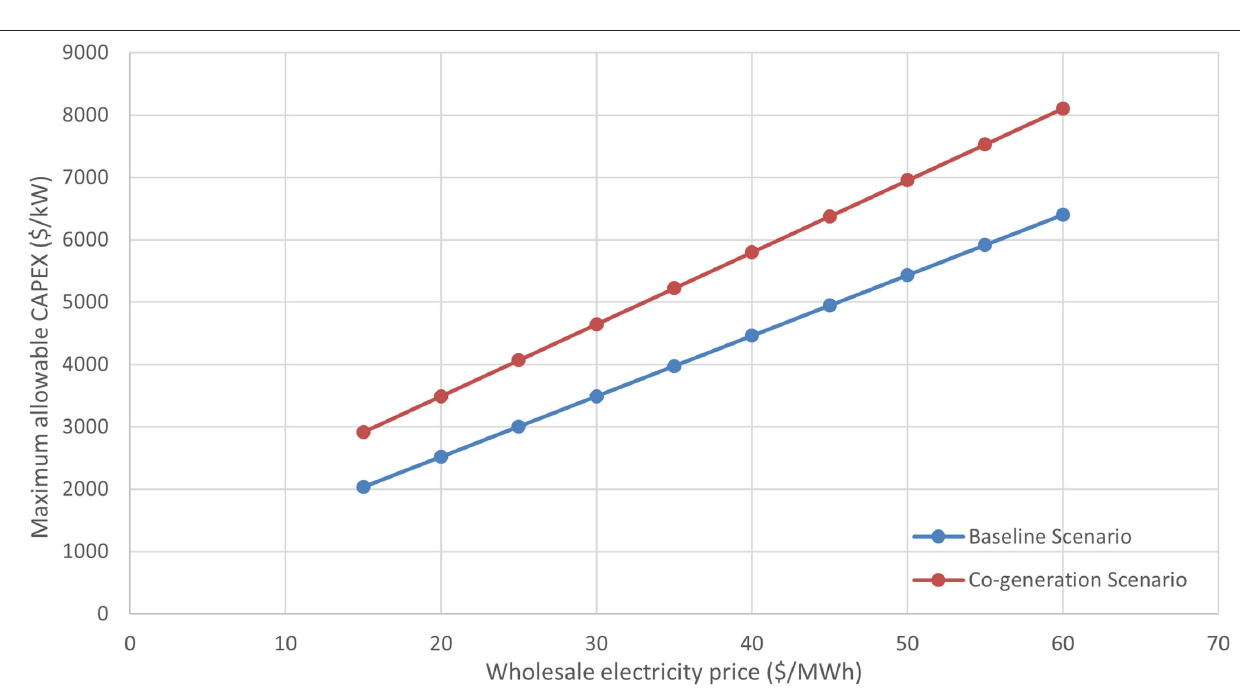
FIGURE 4 | Wholesale electricity price sensitivity for the maximum allowable SMR CAPEX in order to break